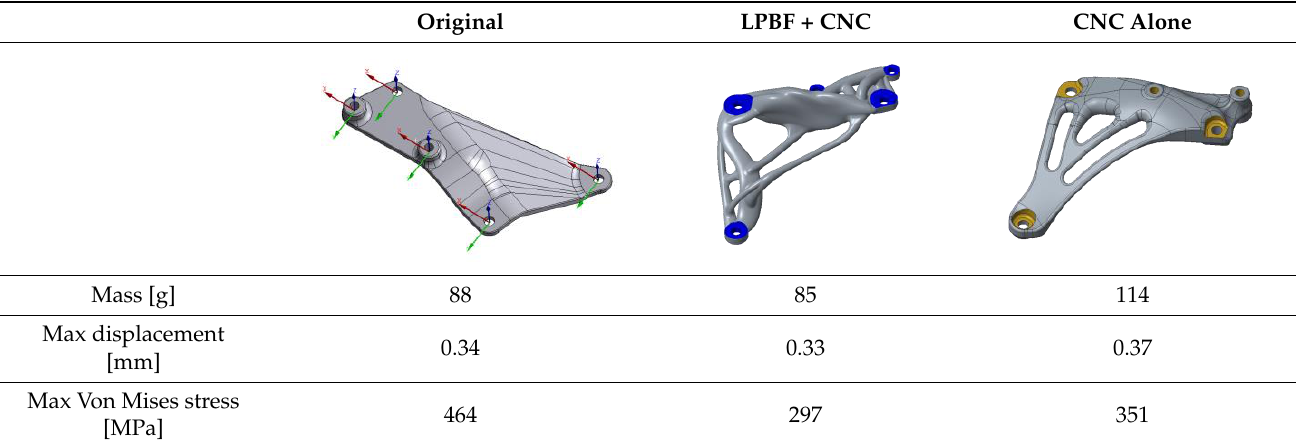
Figure 3. Output of the optical dimensional control: ( a ) as-built part; ( b ) finished part; ( c ) histogram of the distribution of geometrical deviation on the finished part. Table 3. Comparison of mass and mechanical response for the three bracket versions.